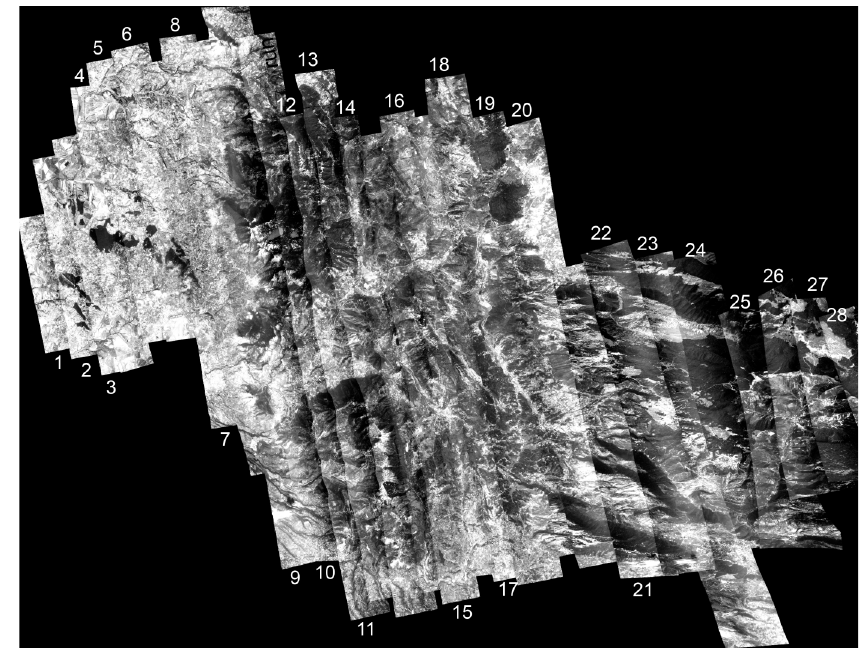
Fig. 2. Mosaic of MIVIS flight